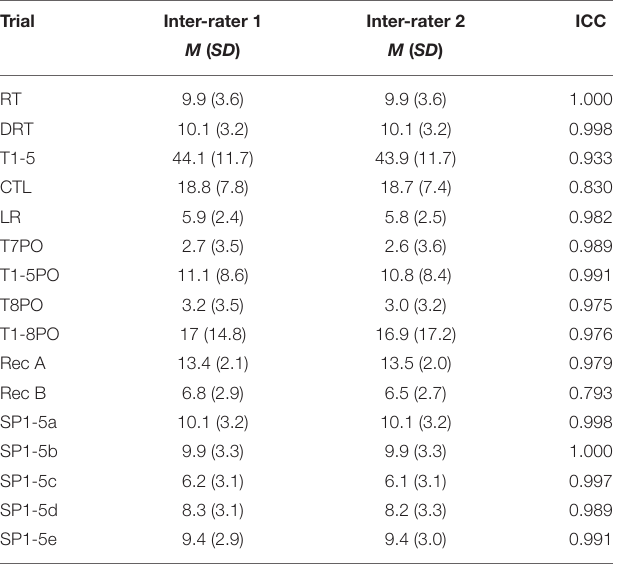
TABLE 1 | Intra-class coefficients (ICC) for inter-rater data sets by dependent variable. Trial